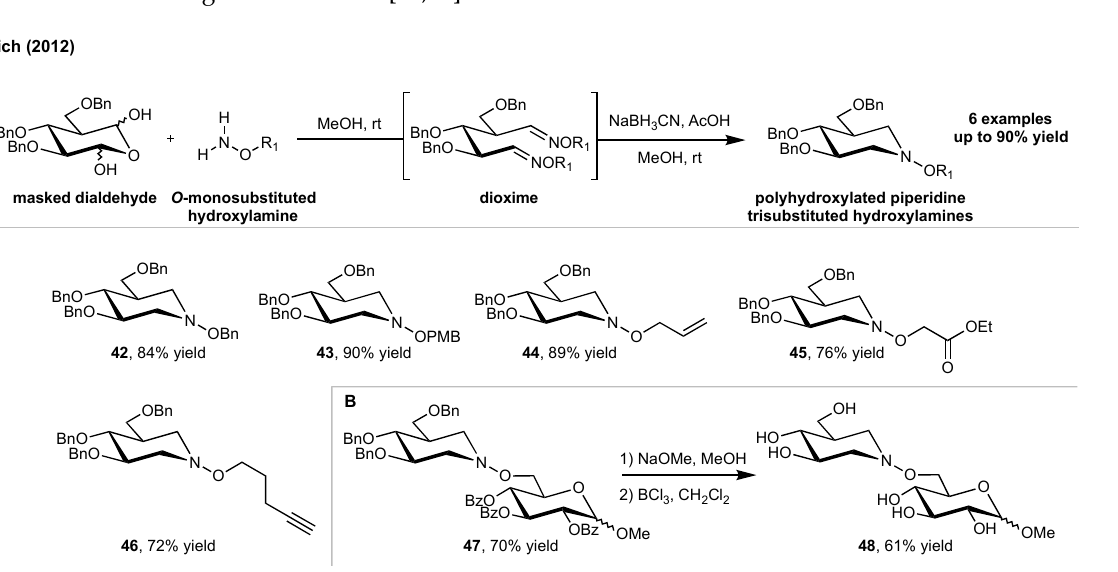
Scheme 4. Crich(cid:31)s double reductive amination procedure for the synthesis of polyhydroxylated pi- peridine-derived trisubstituted hydroxylamines. ( A ) Selected examples of the transformation. ( B ) Application to complex hydroxylamines and deprotection